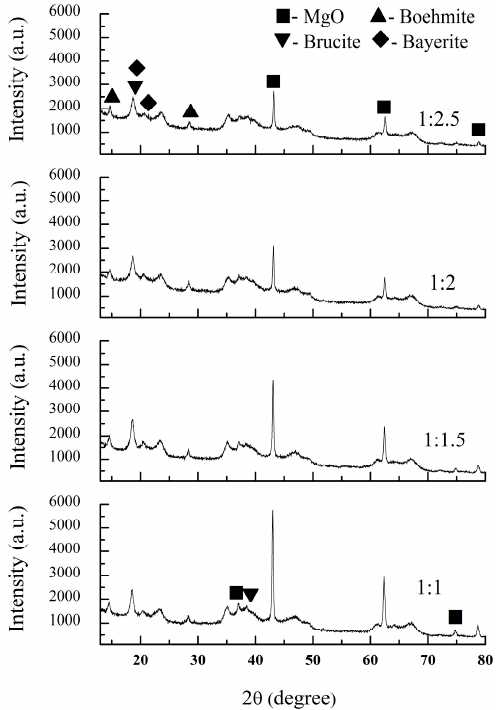
Figure 1. XRD patterns of the dried green bodies with different ratios of starting powders and deionized water: S1 (1:1); S2 (1:1.5); S3 (1:2) and S4 (1:2.5).